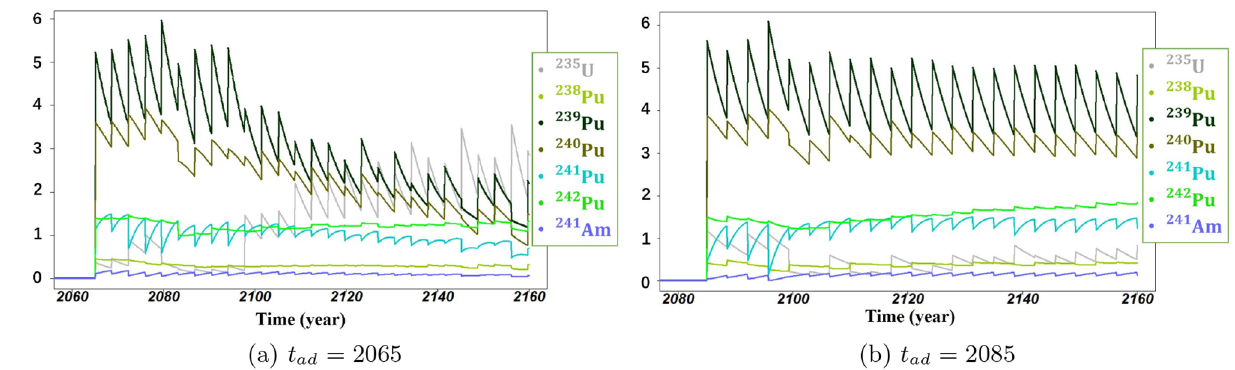
Fig. 8. Content evolution of plutonium isotopes, 235 U and 241 Am in PWR MOXEUS in SCN SFR2MOXEUS for optimal adaptations from year 2065 and 2085 (in % of the heavy nuclides present in the considered